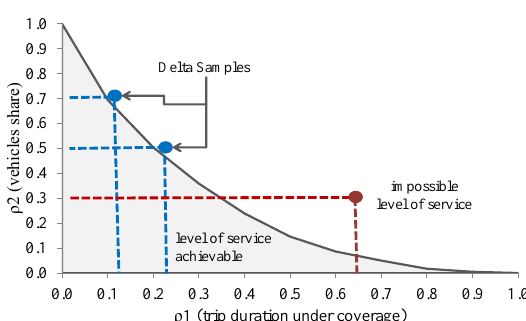
Figure 1. Delta governs the combinations of ρ 1 (share of trip under coverage) and ρ 2 (share of vehicles meeting coverage). Source: Silva et al.